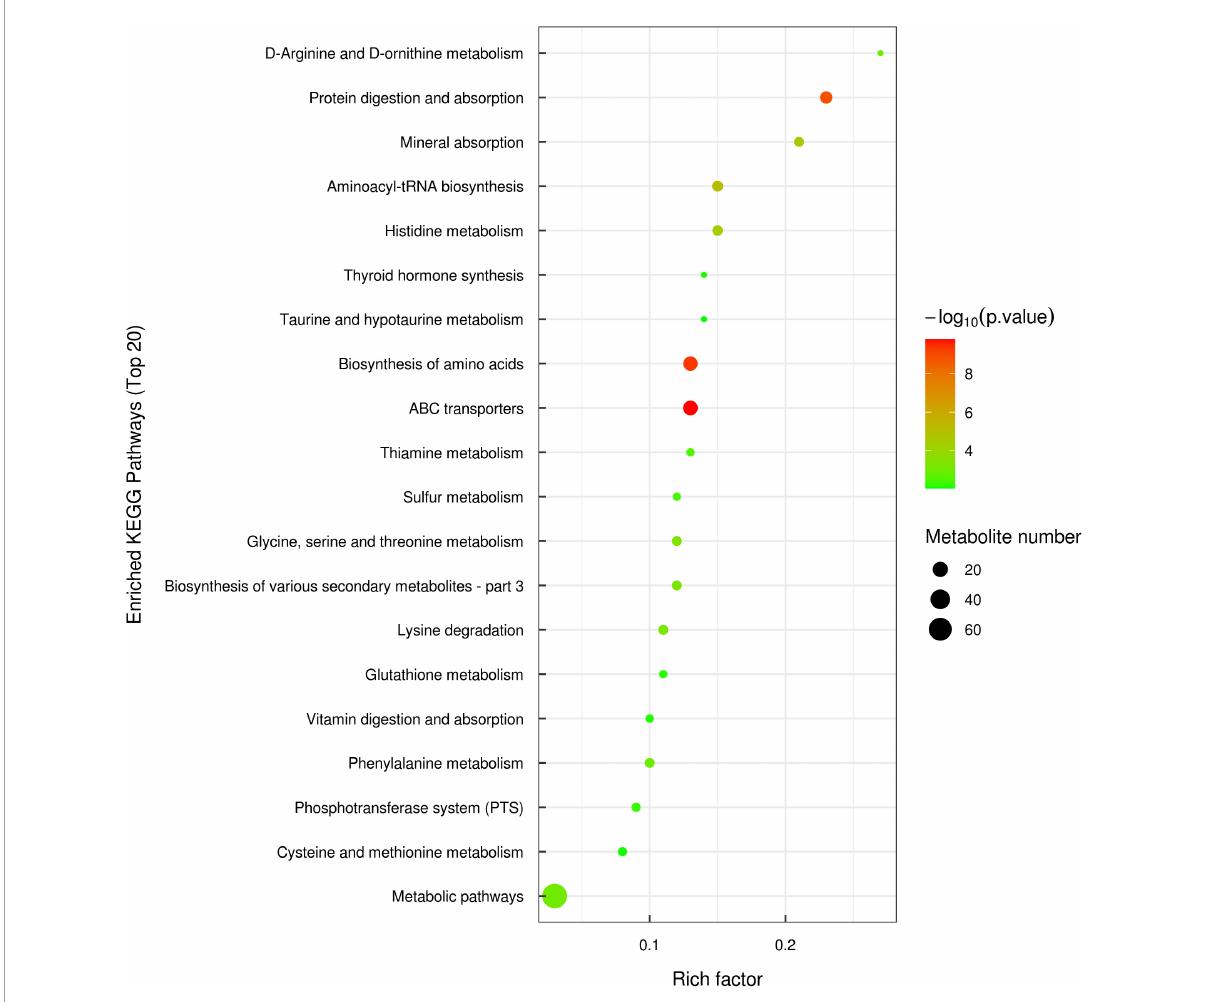
FIGURE4 Bubble diagram of kyoto encyclopedia of genes and genomes (KEGG) metabolic pathway enrichment analysis of significantly different metabolites between TF and SF group (top